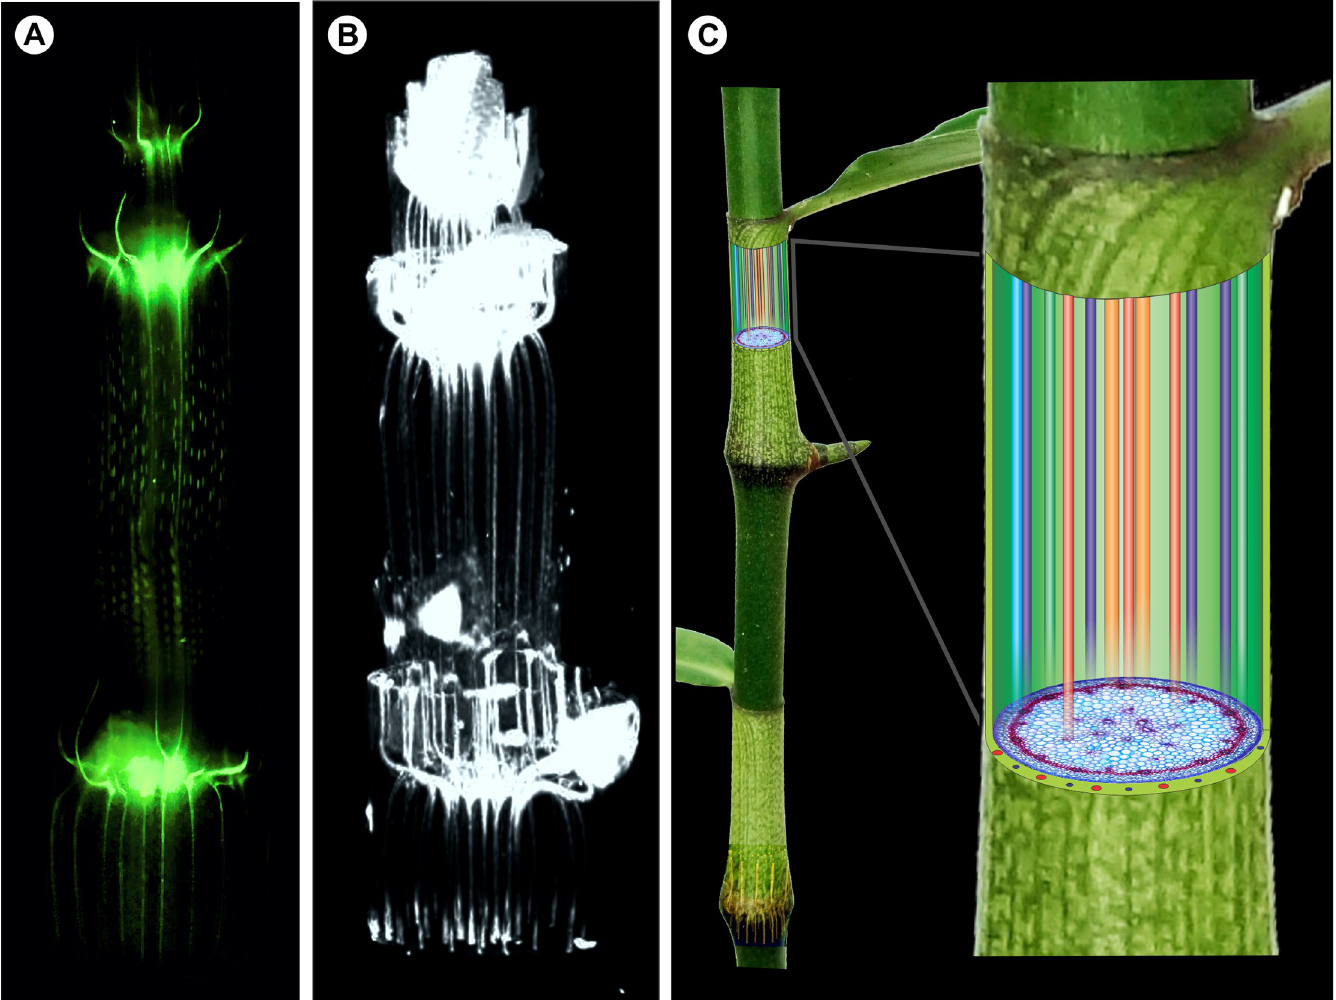
Fig 9. Overview of the course of vascular bundles along the main axis of the stem. A) Whole-mount diaphanization of the shoot apex of Tradescantia zebrina Heynh. ex Bosse. B) μ CT analysis by contrast attenuation of the shoot apex of T . zebrina , contrasted with lead citrate. C) Illustration indicating the straight course of vascular bundles in the internode of Dichorisandra thyrsiflora J.C. Mikan.